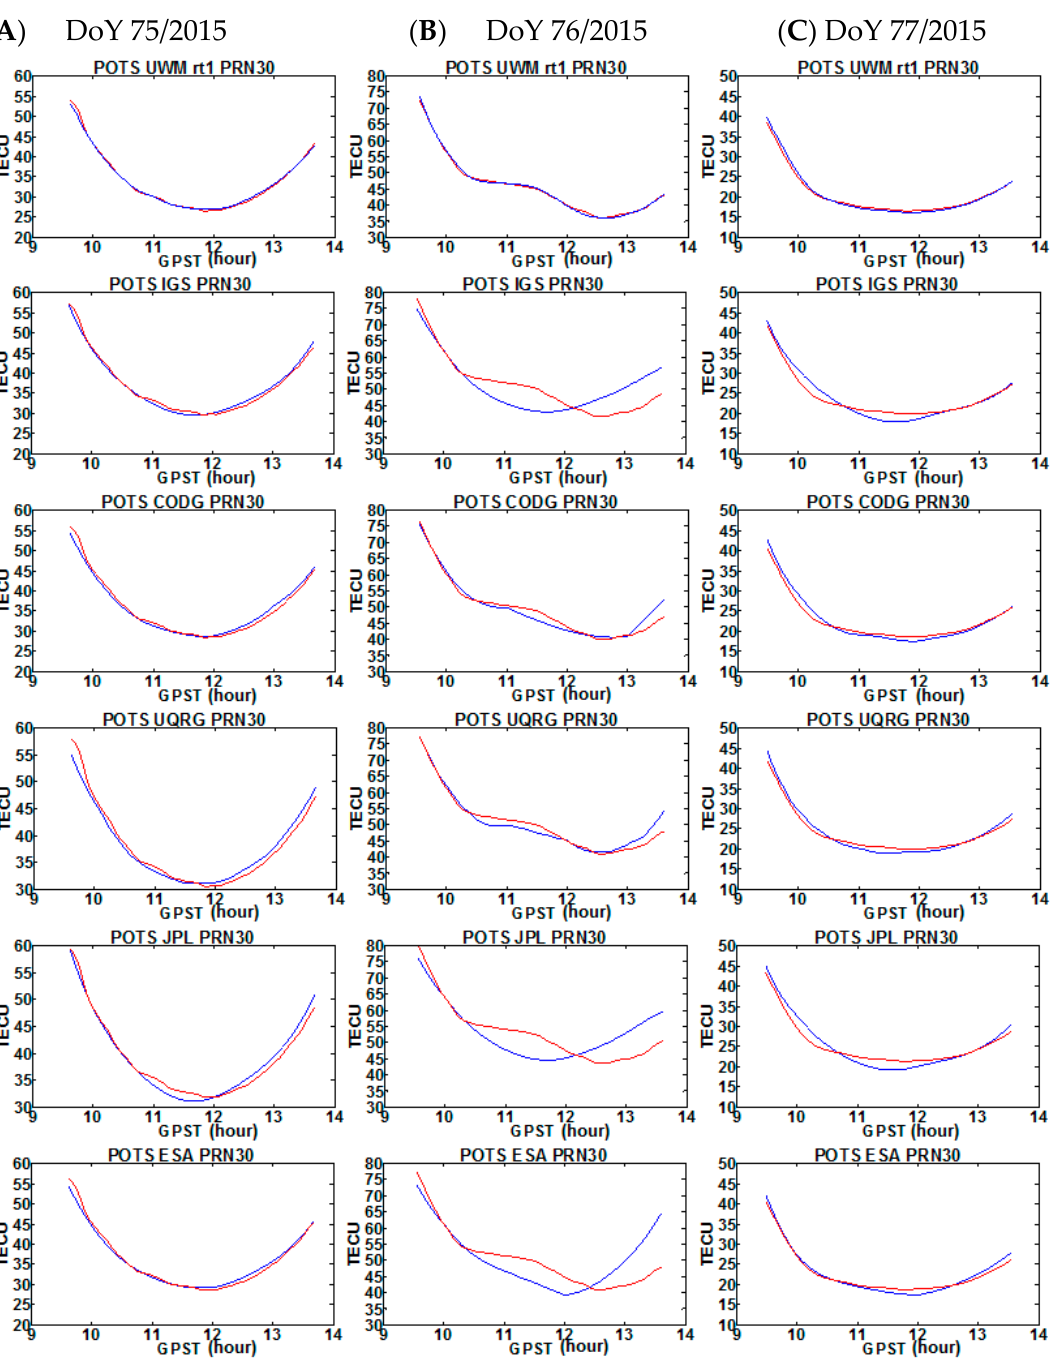
Figure 6. sTEC for selected PRN arcs from calibrated geometry-free L4 (L4_sTEC—red) and selected GIMs (GIM_sTEC—blue) on the quiet day before the storm ( A ), the stormy day ( B ) and one day after the storm ( C ).